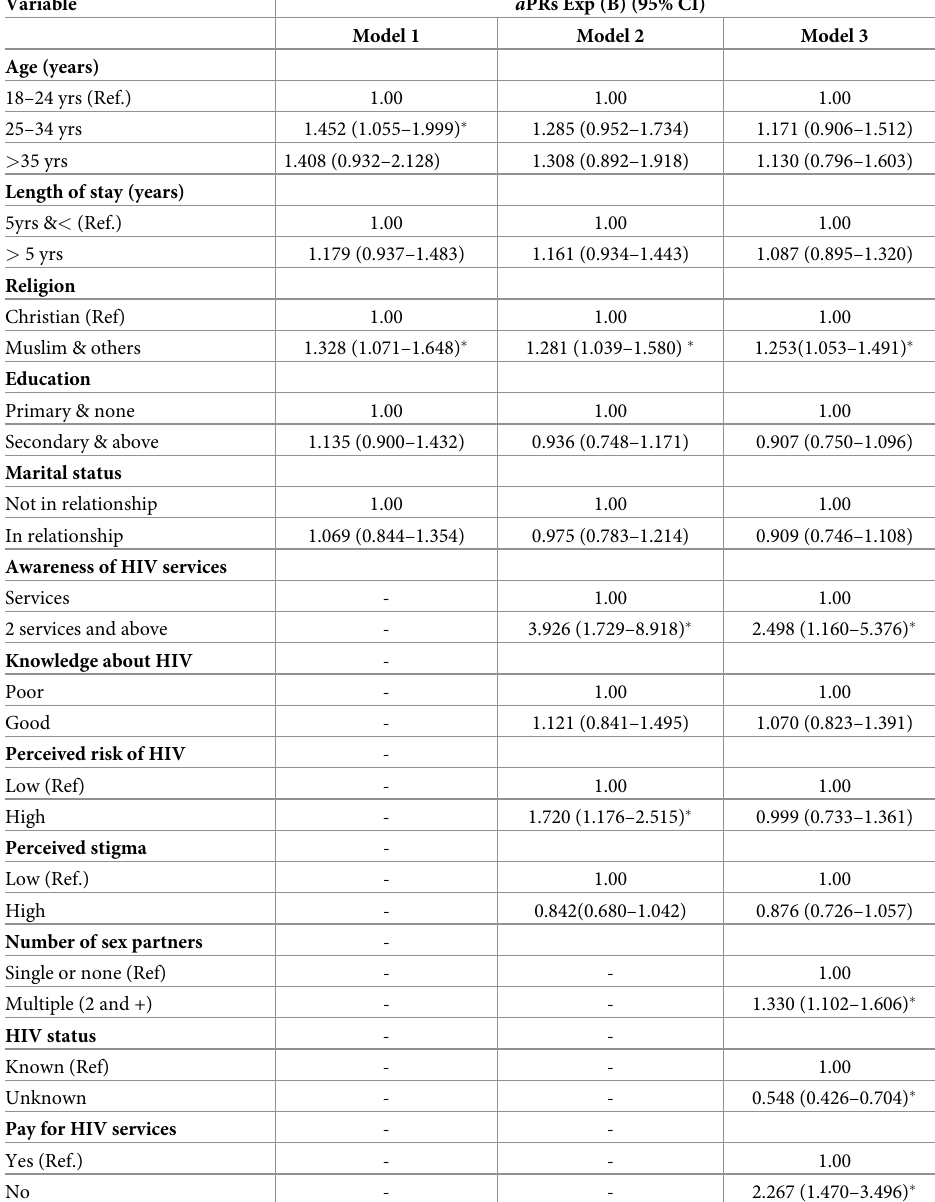
Table 5. Prevalence ratios (and 95%confidence interval) from modified Poisson regression analysis of individual factors that predict the use of multiple HIV prevention services.